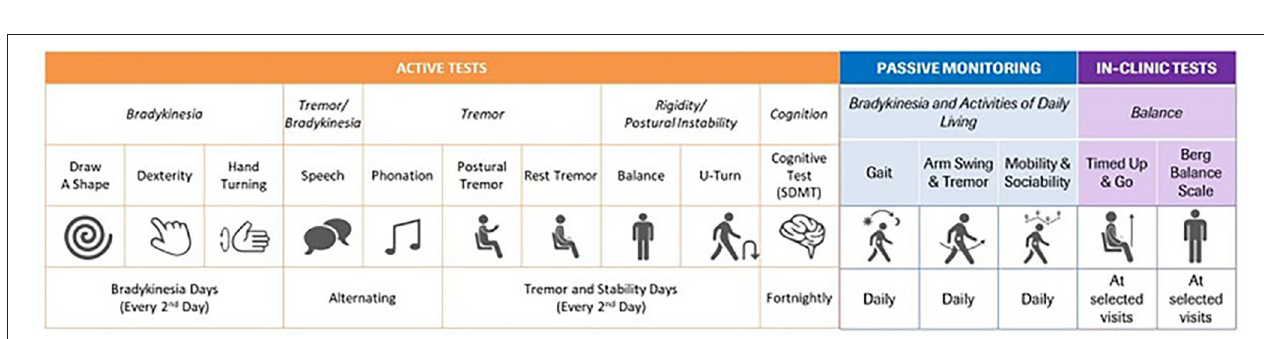
FIGURE 3 | Schedule of activities in PASADENA Part 2. *Digital includes PASADENA Digital Motor Score, Patient Global Impression of Severity, Daily diary, Patient Assessment of Constipation Symptoms (PAC-SYM), EuroQol-5D (EQ-5D), and Hospital Anxiety and Depression Scale (HADS). † Magnetic resonance imaging (MRI) includes safety, diffusion tensor imaging (DTI), resting state and arterial spin labeling (ASL). CGI-I, Clinical Global Impression of Improvement; DaT-SPECT, dopamine transporter imaging with single-photon emission computerized tomography; MDS-UPDRS, Movement Disorder Society—Unified Parkinson’s Disease Rating Scale; MoCA, Montreal Cognitive Assessment; PDQ39, Parkinson’s Disease Questionnaire − 39; PDSS-2, Parkinson’s Disease Sleep Scale Revised Version 2; PGI-C, Patient Global Impression of Change; SCOPA-AUT, Scales for Outcomes in Parkinson’s Disease—Autonomic Dysfunction; SE-ADL, Schwab and England Activities of Daily Living.